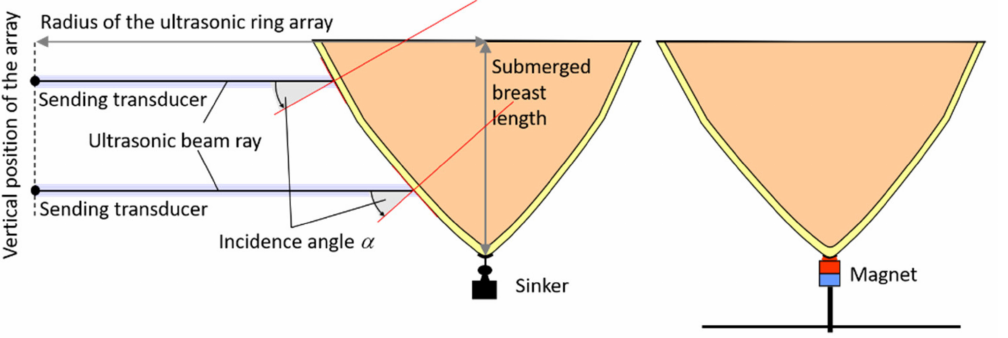
Figure 19. Simple ways to stretch a breast submerged in a tank with a sinker or with a